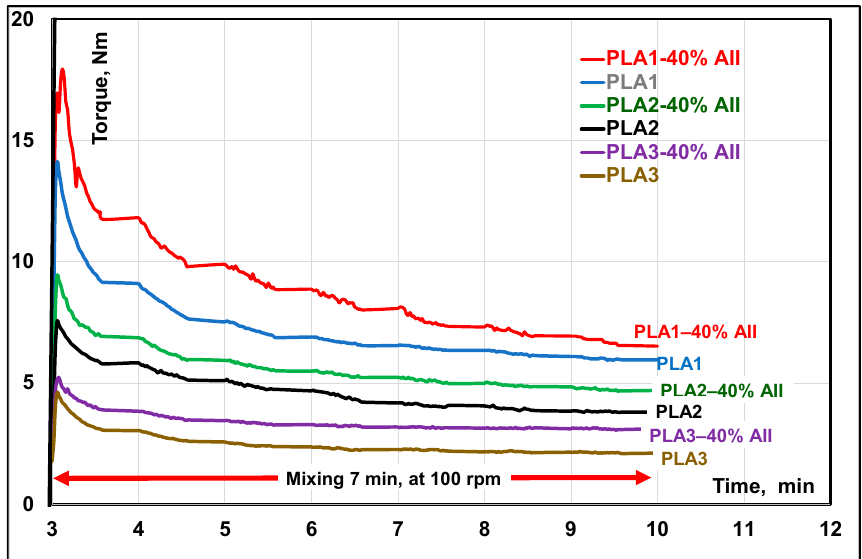
Figure 3. Comparative evolution of torque during melt-mixing of PLAs and PLA-AII composites using Brabender internal mixers.